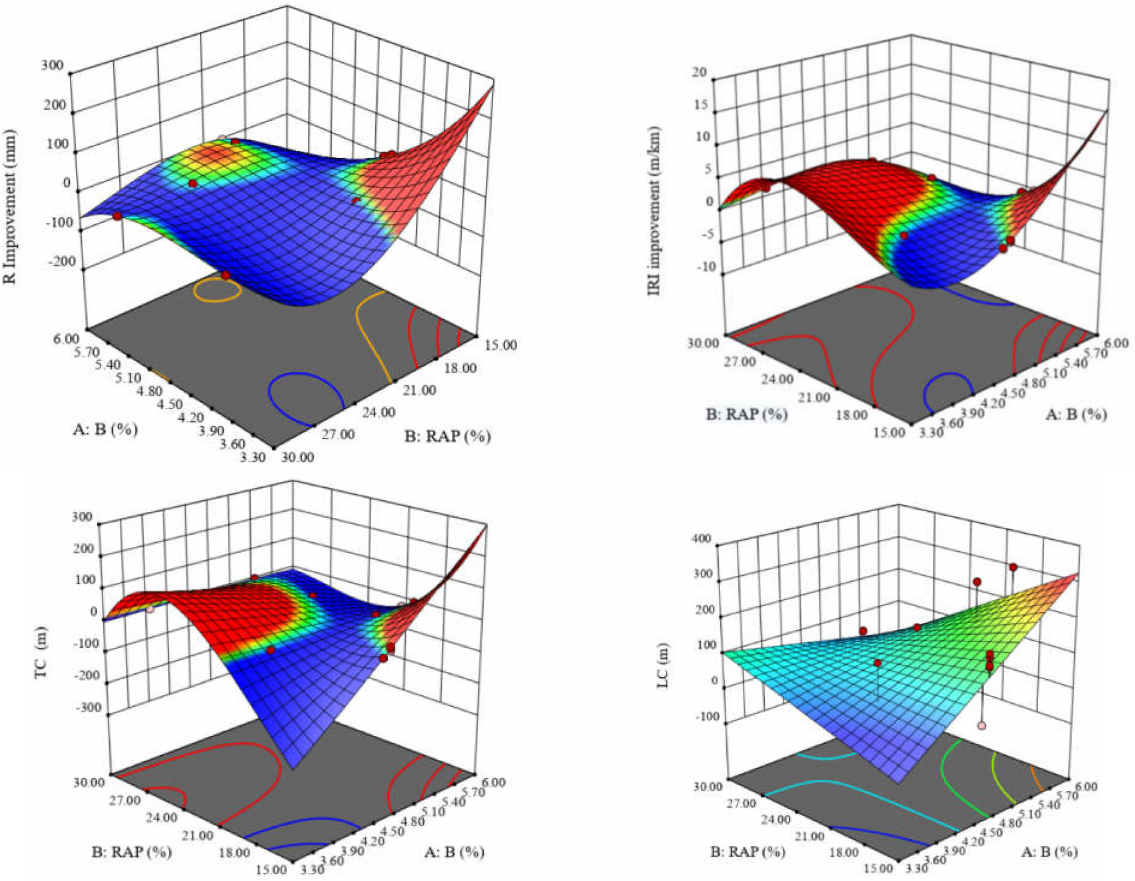
Figure 12. Response surfaces for WMA overlay containing RAP in dry